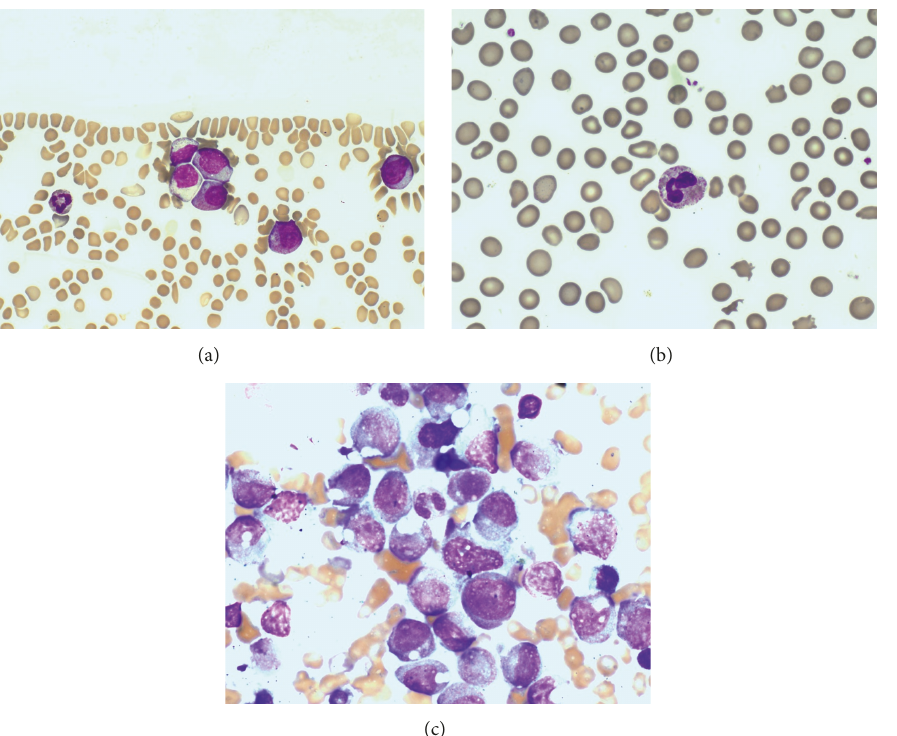
Figure 1: (a) Peripheral blood promyelocytes; (b) peripheral blood pseudo-Pelger-Huet neutrophils; (c) bone marrow effacement by pro- myelocytes at